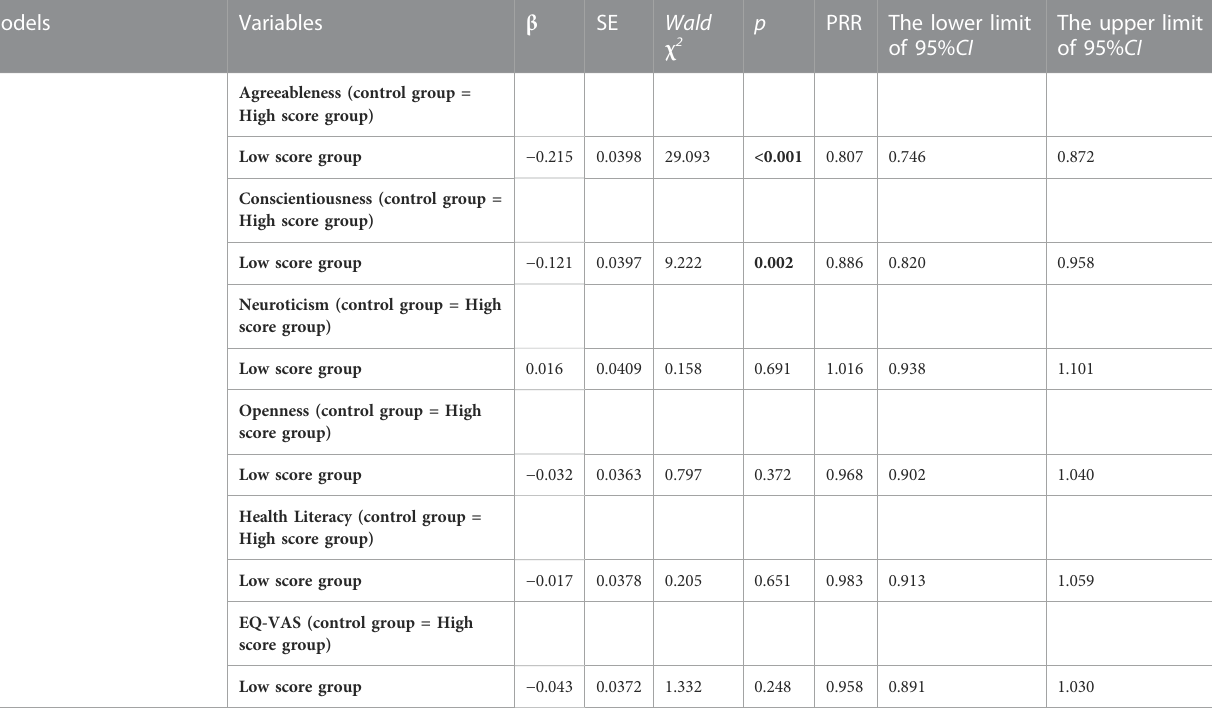
TABLE 6 ( Continued ) Results of analysis of subgroups by region (dependent variable: likelihood of residents focusing on ef fi cacy).